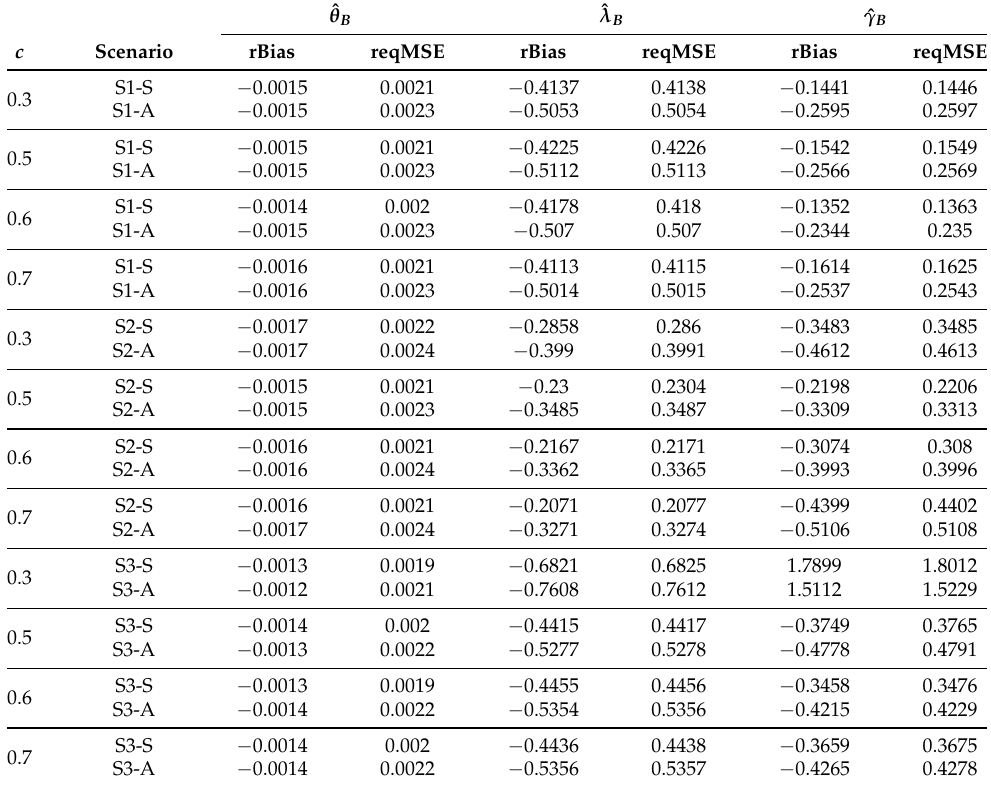
Table 3. The values of rBias and rsqMSE based on ˆ θ B , ˆ λ B and ˆ γ B for n =